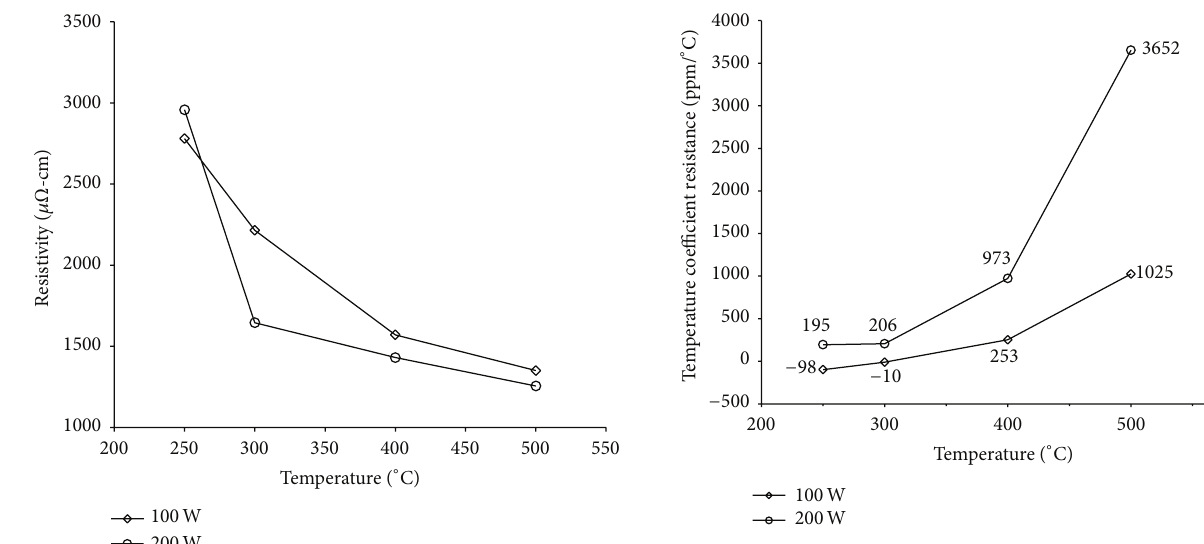
Figure 7: Temperature dependence of the TCR of Ni-Cr-Si-Al-Ta films with different sputtering powers and annealing